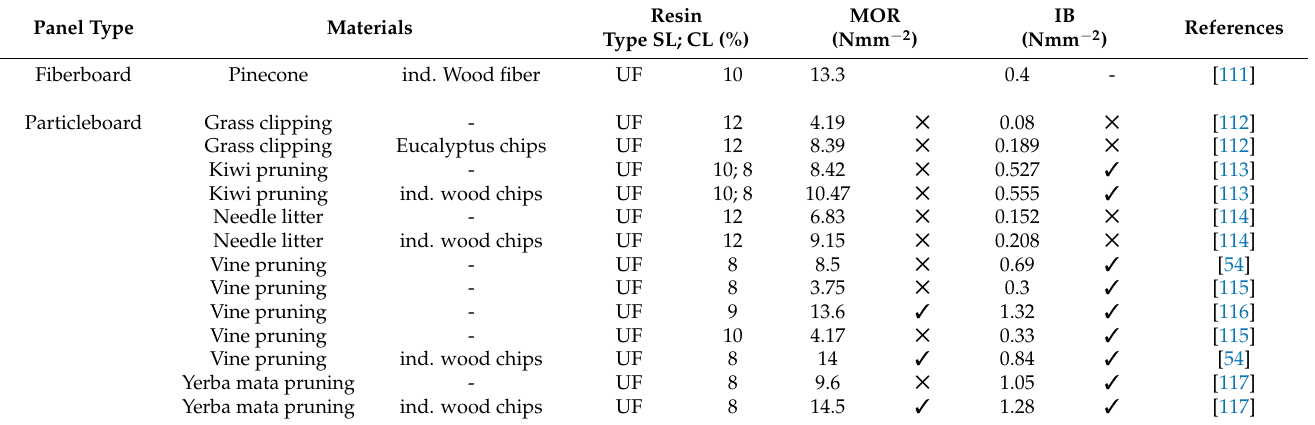
Table 6. Grow care residues used for panel production with information on whether MOR and IB meet ( (cid:51) ) or not ( (cid:53) ) the standard requirements (fiberboard EN 622-3:2004; particleboard EN